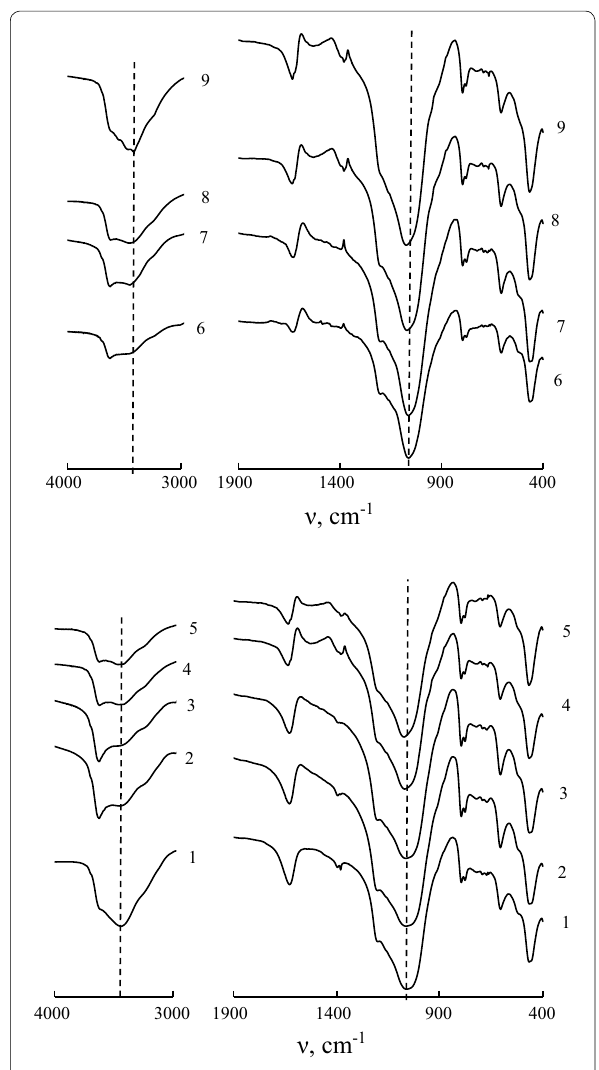
Fig. 2 IR spectra for natural ( 1 ) and acid-modified 0.25H-CLI ( 2 ), 0.5H-CLI ( 3 ), 1H-CLI ( 4 ), and 3H-CLI ( 5 ) clinoptilolite samples as well as: Pd(II)–Cu(II)/0.25H-CLI ( 6 ), Pd(II)–Cu(II)/0.5H-CLI ( 7 ), Pd(II)–Cu(II)/1H-CLI ( 8 ), and Pd(II)–Cu(II)/3H-CLI ( 9 )